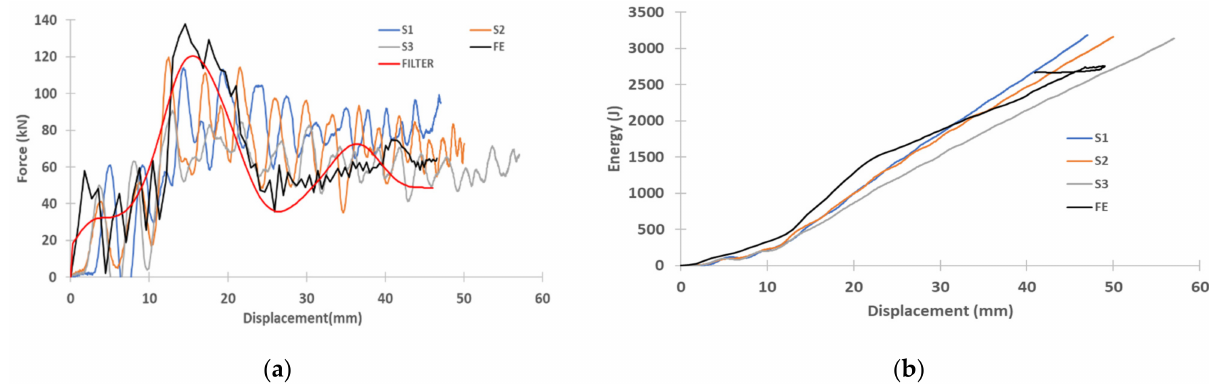
Figure 9. Hat-shaped crush at kinetic energy of 3 kJ: ( a ) Dynamic experimental and F.E load vs. displacement curves, ( b ) Dynamic experimental and F.E energy vs. displacement curves.